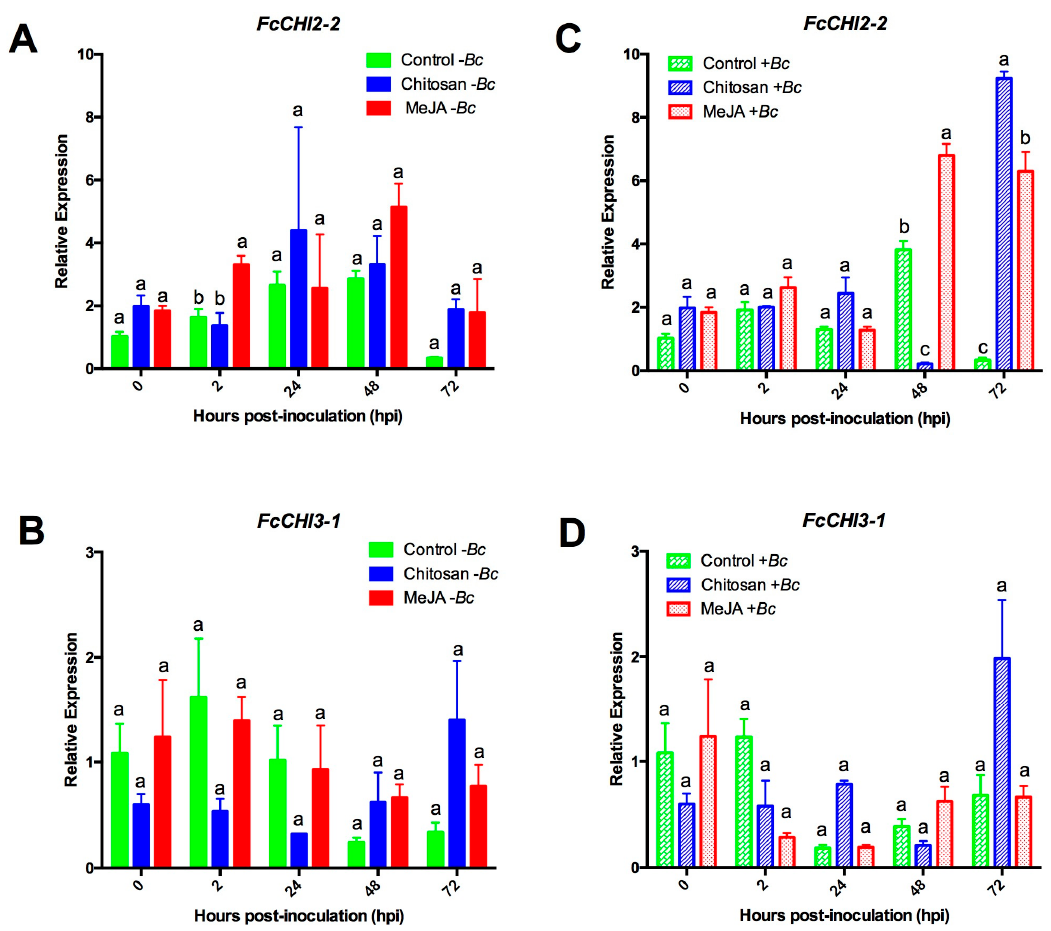
Figure 4. Expression profiles of chitinase-encoding genes ( CHI s) in Fragaria chiloensis fruit treated with methyl jasmonate (MeJA) or chitosan at different hours post inoculation (hpi) with or without Botrytis cinerea spores . Changes in relative expression of FcCHI2-2 and FcCHI3-1 in fruit inoculated without (– Bc ) ( A , B ) and with (+ Bc ) B. cinerea spores ( C , D ), respectively, at 0, 2, 24, 48, and 72 hpi. Data were analyzed by ANOVA test and differences between means ± SE ( n = 3) were determined using the Tukey test. Different letters indicate significant differences between treatments ( p < 0.05) for each hpi. For experimental details, see the Materials and Methods Section.